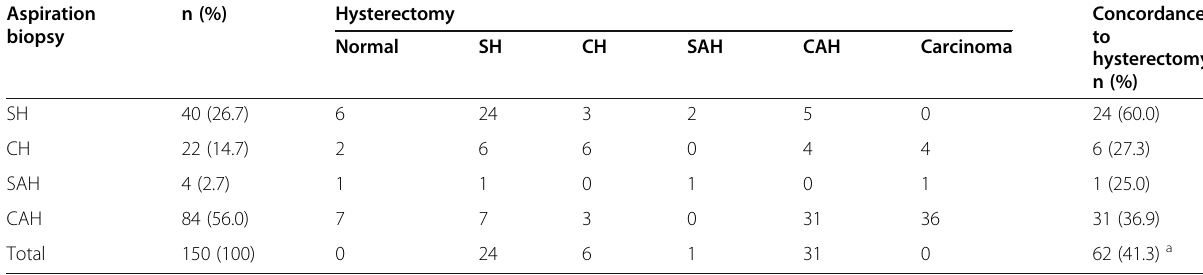
Table 3 Comparison of pathological results of aspiration biopsy and hysterectomy Aspiration biopsy